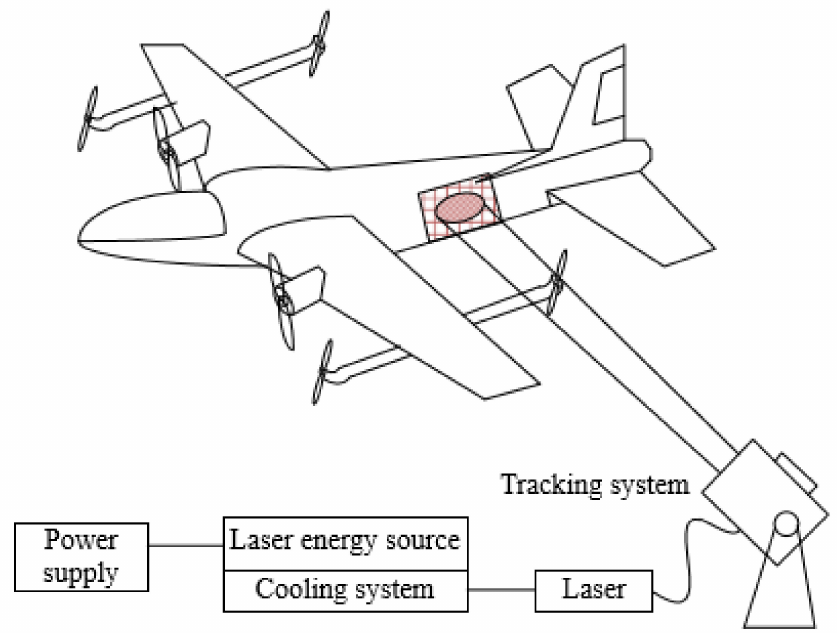
Figure 12. Structure diagram for remote transmission of UAV laser wireless energy